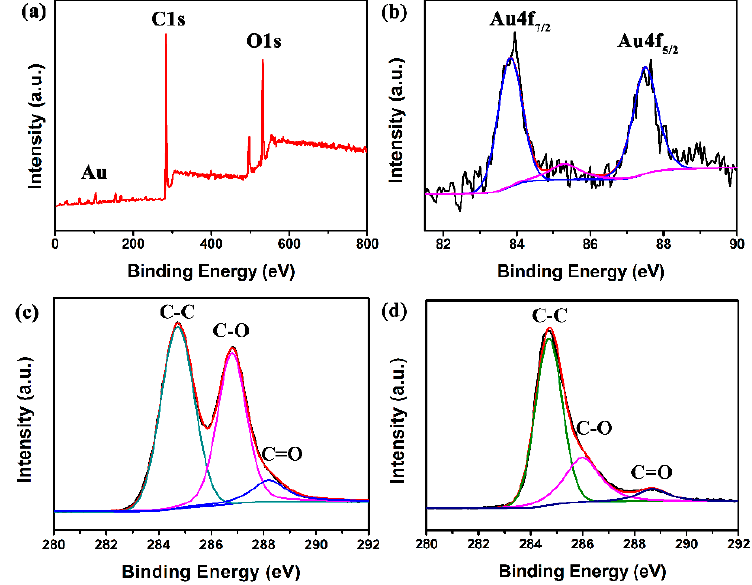
Figure 5. ( a ) XPS spectras of rGO/Au; ( b ) Au4f spectrum of rGO/Au; ( c ) C1s spectrum of GO; ( d ) C1s spectrum of rGO/Au.